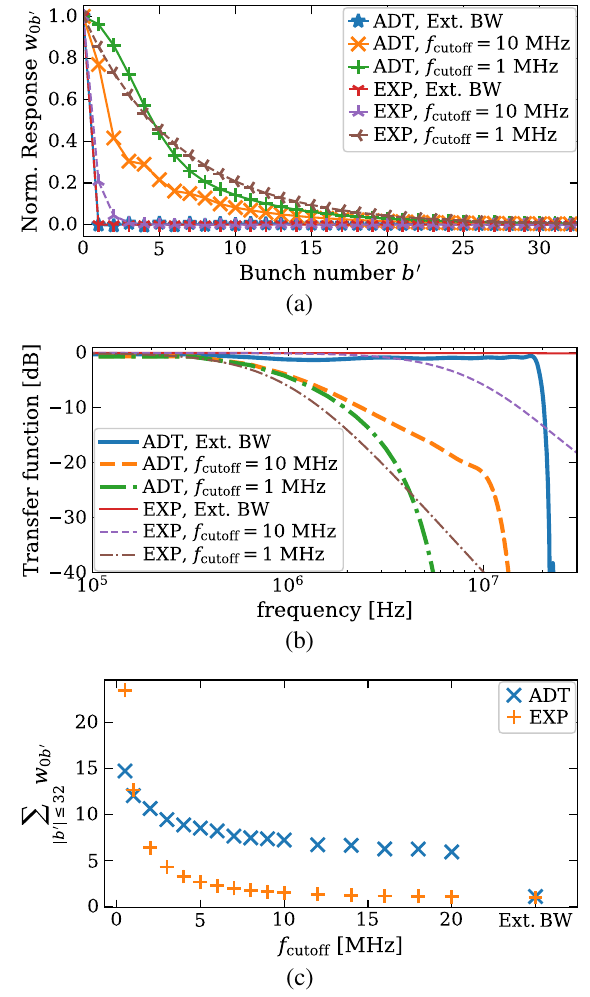
FIG. 1. Response functions of two types of filters in time domain in (a) and in frequency domain in (b), assuming a bunch separation of Δ t ¼ 25 ns. The sums of the response functions in time domain, over all neighbors maximally 32 slots away, are given in (c). The EXP filter is an exponential filter, while the ADT filter replicates the transverse feedback in the LHC, both of which are fully symmetric in time in the range j b − b 0 j ≤ 32 , although only b 0 − b ≥ 0 is shown